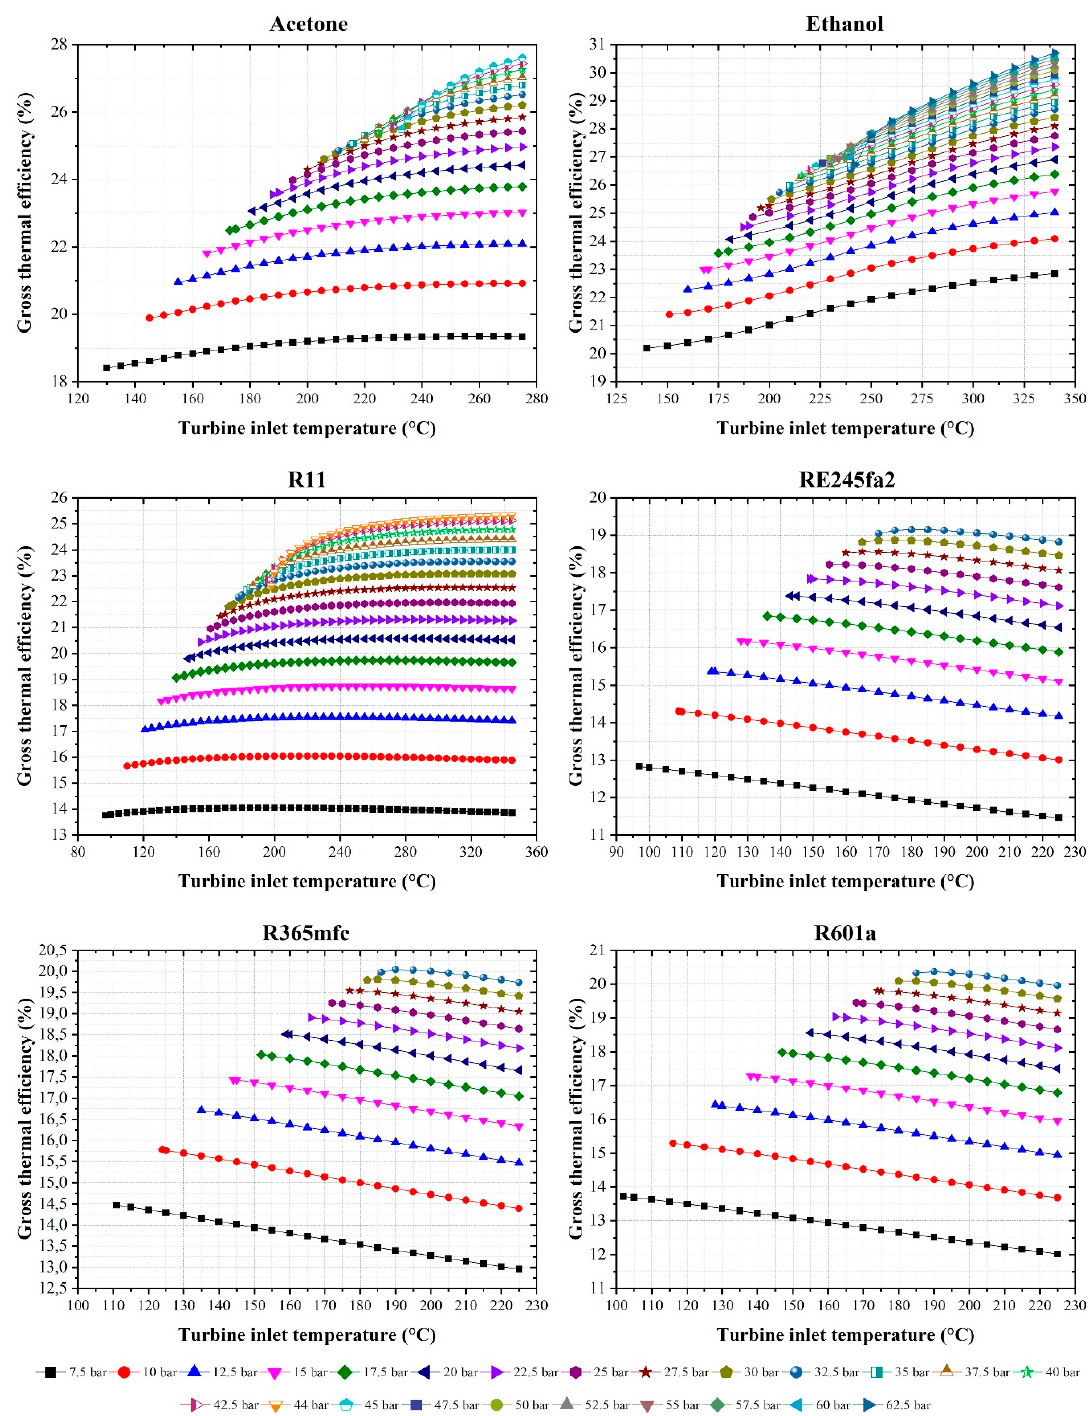
Figure 6. The gross thermal e ffi ciency calculated from the ORC for varying turbine inlet temperatures and turbine inlet pressures.